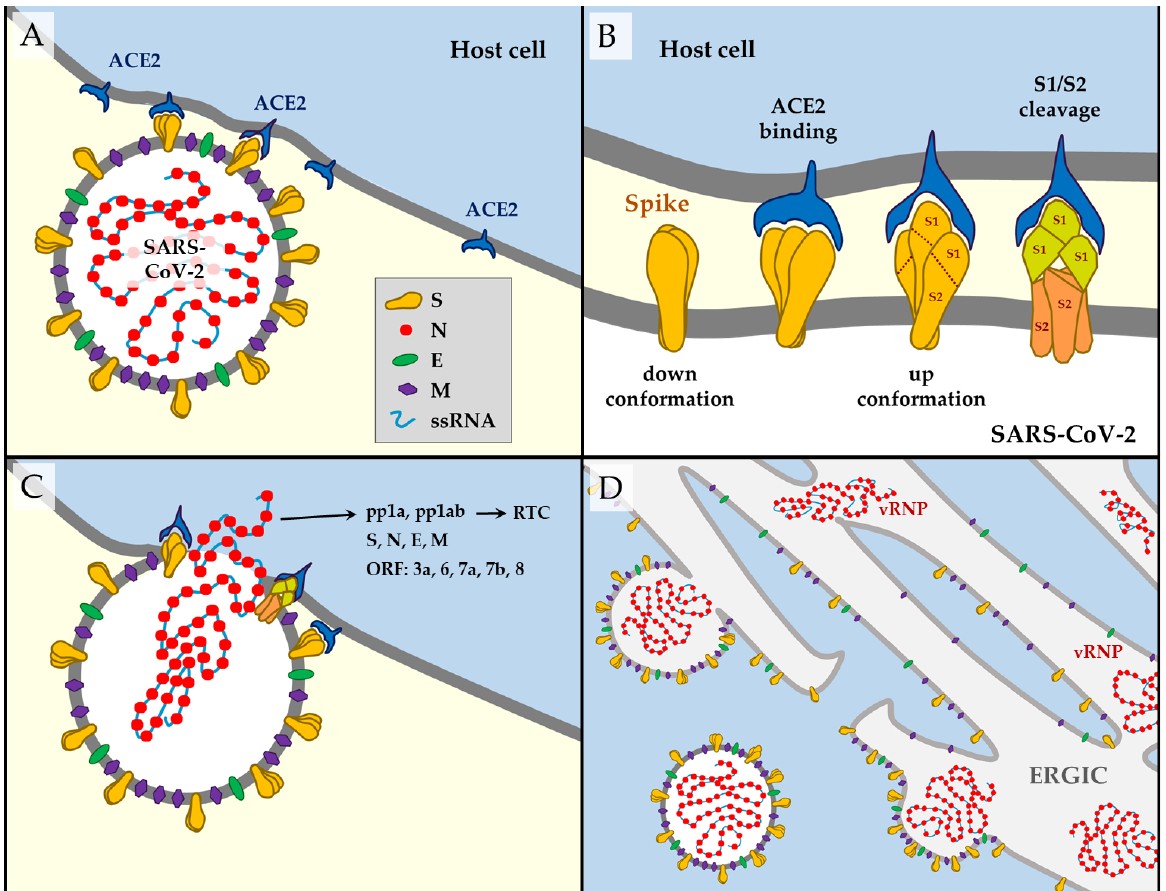
Figure 1. ( A ) SARS-CoV-2 structure of the SARS-CoV-2, comprising an ssRNA and 4 structural proteins interacts with the host cell through the ACE2 receptor (dark blue). Blue field represents inside the host cell, and yellow field outside the cell. ( B ) Changes in the spike during the virus-cell interaction. At the left, the inactive or ‘down’ conformation, reluctant to bind ACE2. Spike–ACE2 binding produces a conformational change in the S towards the ‘up’ configuration. This is followed by S1/S2 cleavage by host enzymes and activation of the entry to the cell. ( C ) Viral ssRNA enters the cell and produces pp1a and pp1ab, which will provide the RTC plus structural proteins (S, N, E, M) and accessory proteins (ORF). ( D ) N proteins are assembled with the new replicated viral ssRNA to form the vRNP. New viruses bud from the ERGIC and are released from the cell.